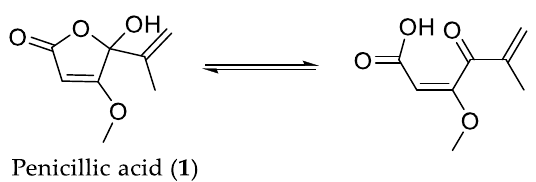
Figure 3. Tautomerization of penicillic acid ( 1 ) .